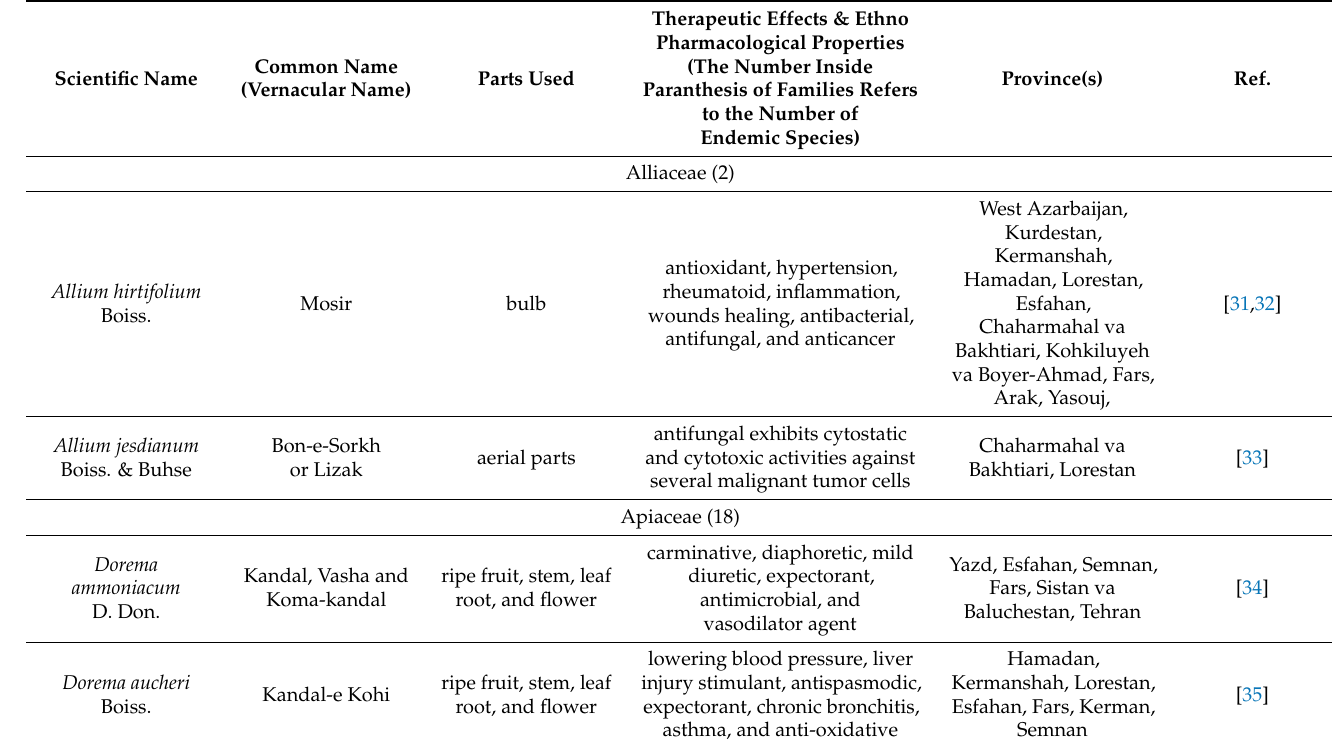
Table 1. List of endemic medicinal and aromatic plants identified from